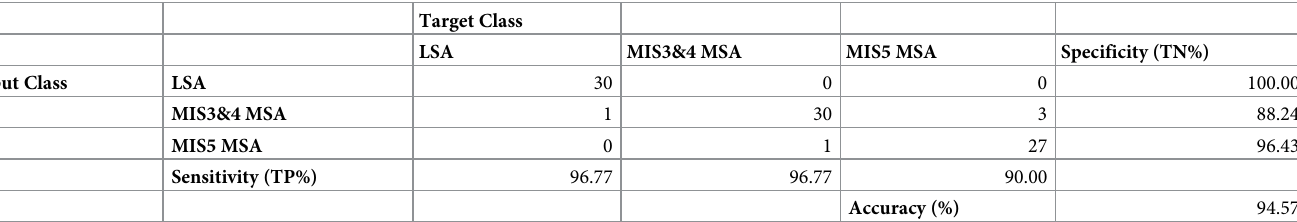
Table 1. Confusion table (3-way).